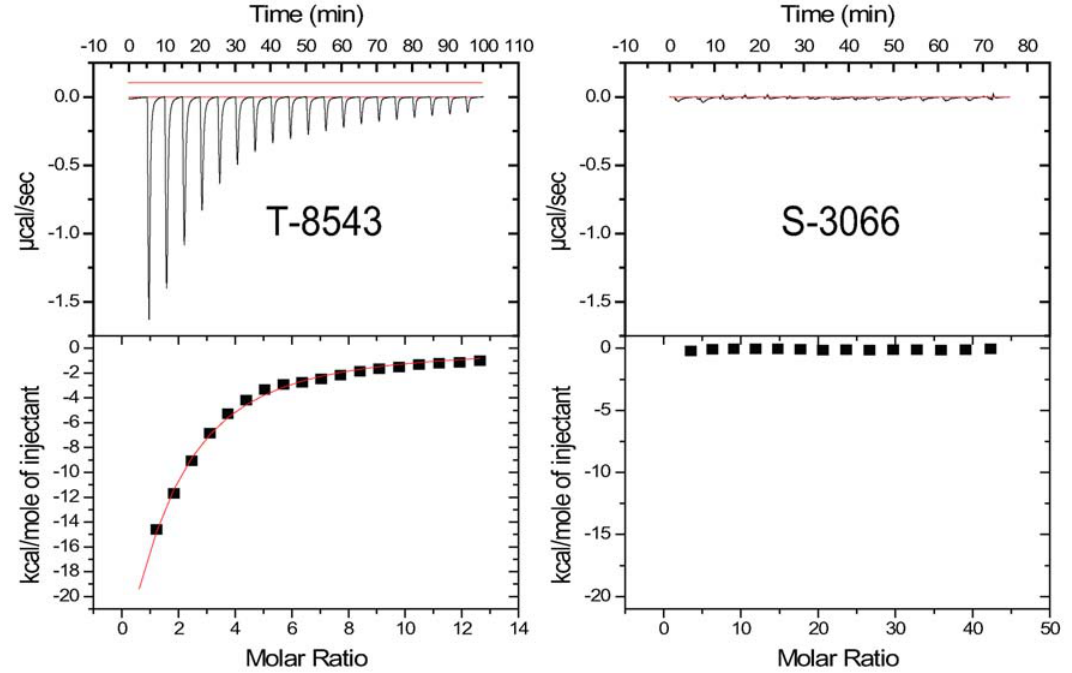
Figure 5. Typical ITC enthalpograms. LOPAC compound T-8543 shows clear exothermic binding behavior (A), while S-3066 does not (B).